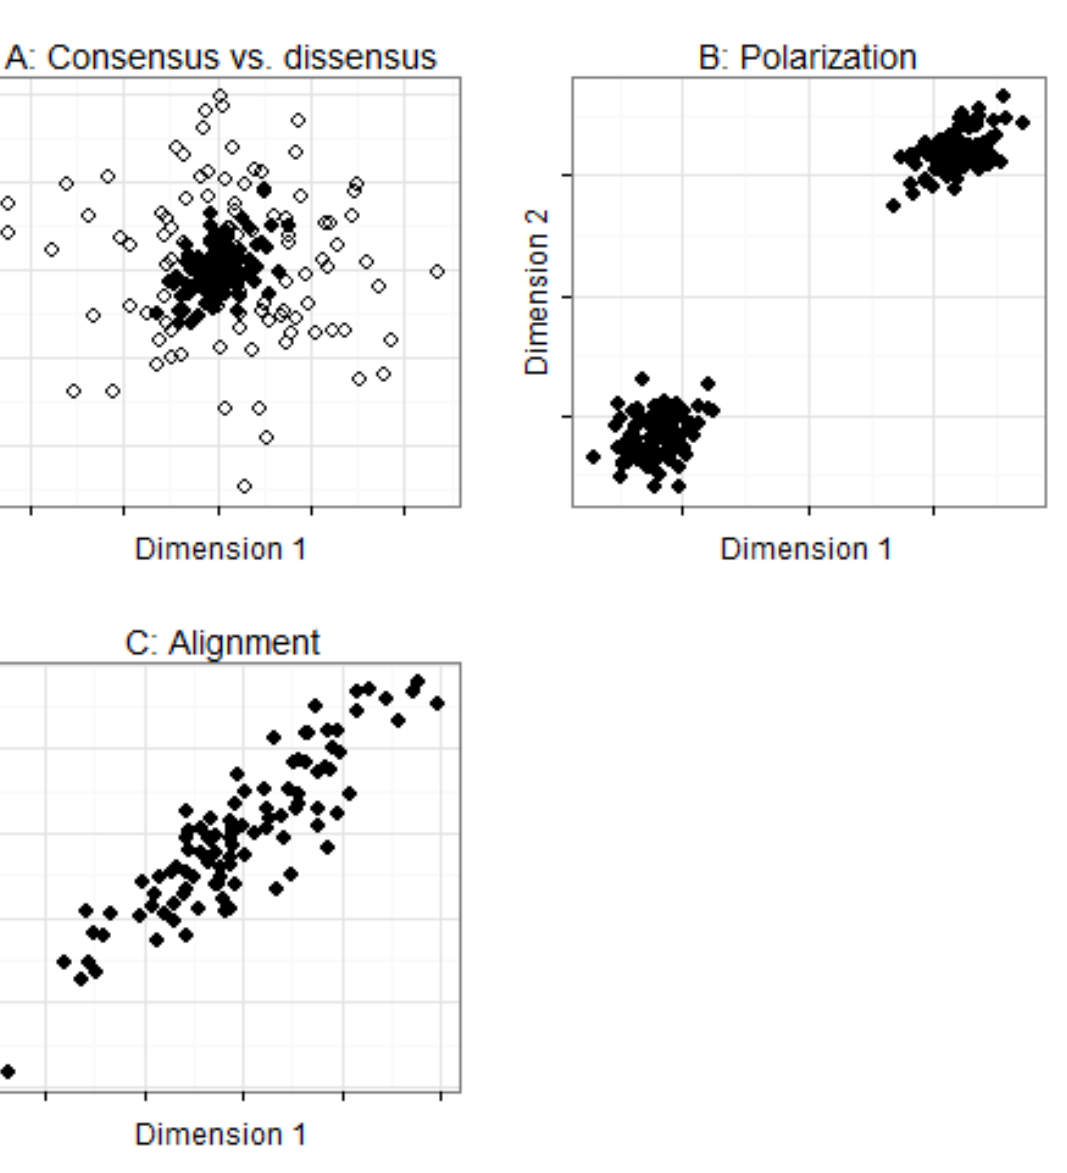
Figure 1: Hypothetical idea